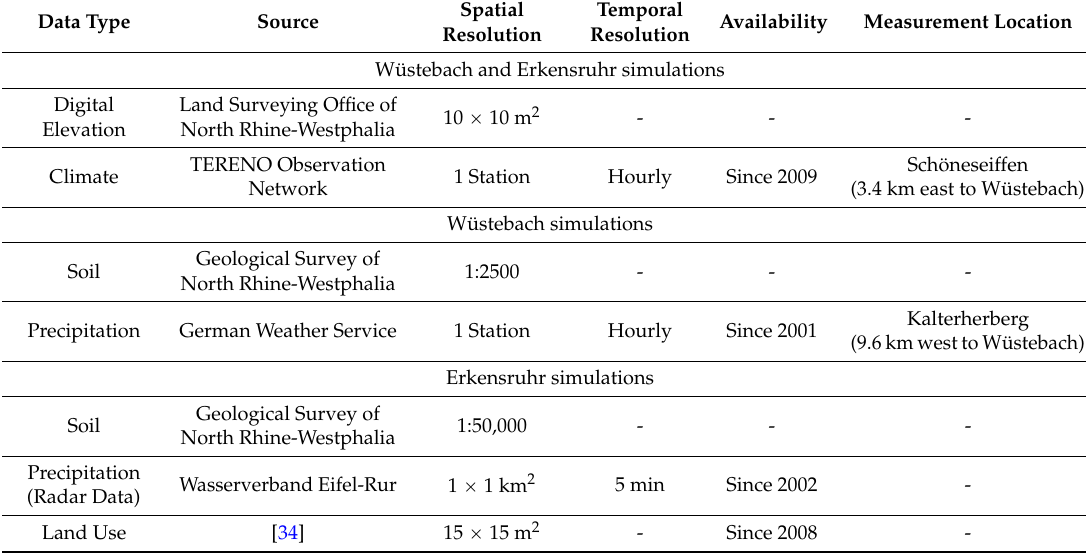
Table 1. Data sources, availability, spatial and temporal resolution and measurement location of input data used in the Wüstebach and Erkensruhr